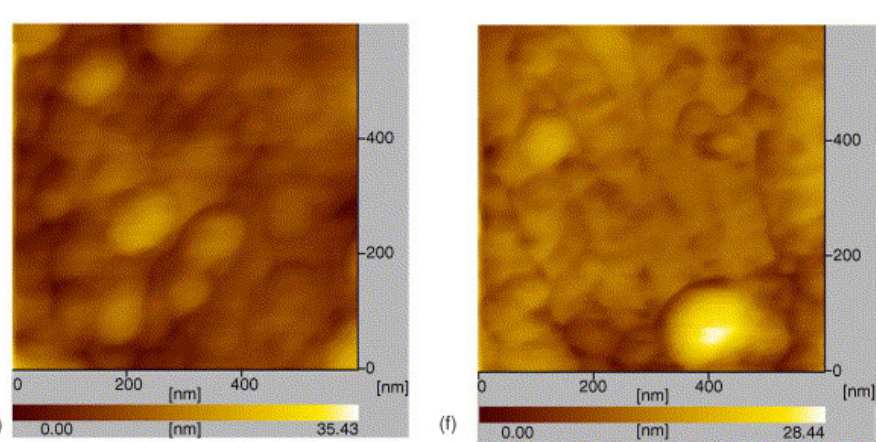
particles of two different 2